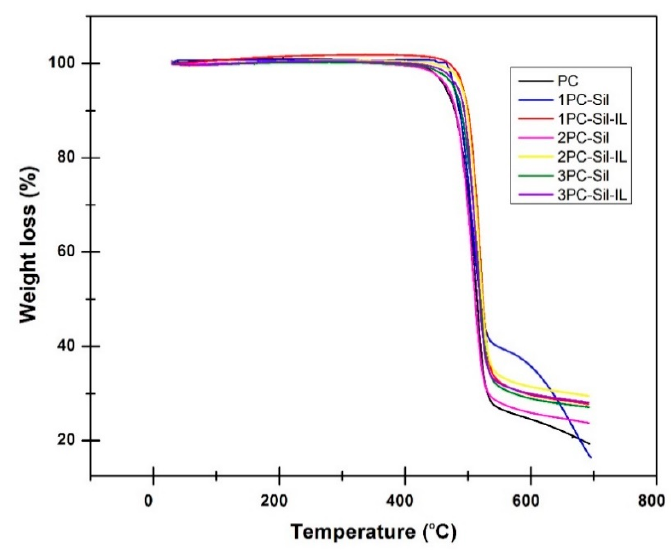
Figure 4. Thermal stability of the developed membranes.